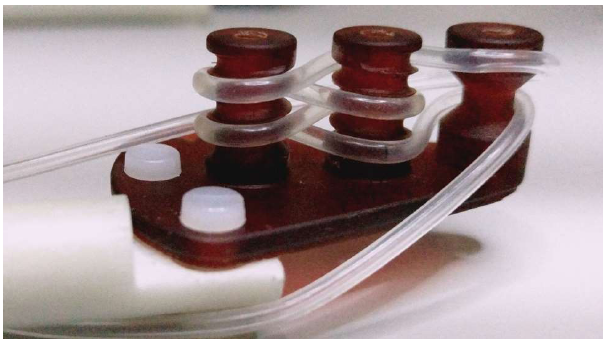
Figure 1. Tube phantom filled with redispersed tracer in water, mounted on the robot arm.